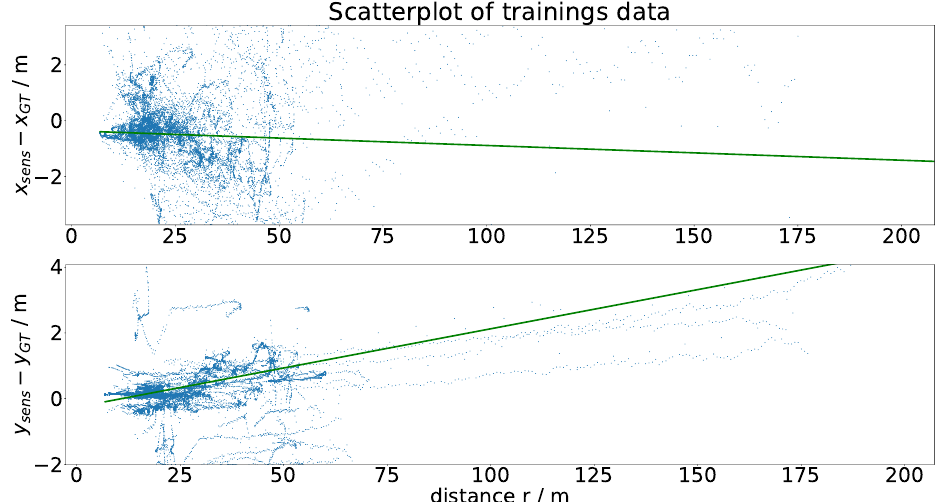
Figure 19. Scatterplot and the line of the best fit, as a basis for the distance-based